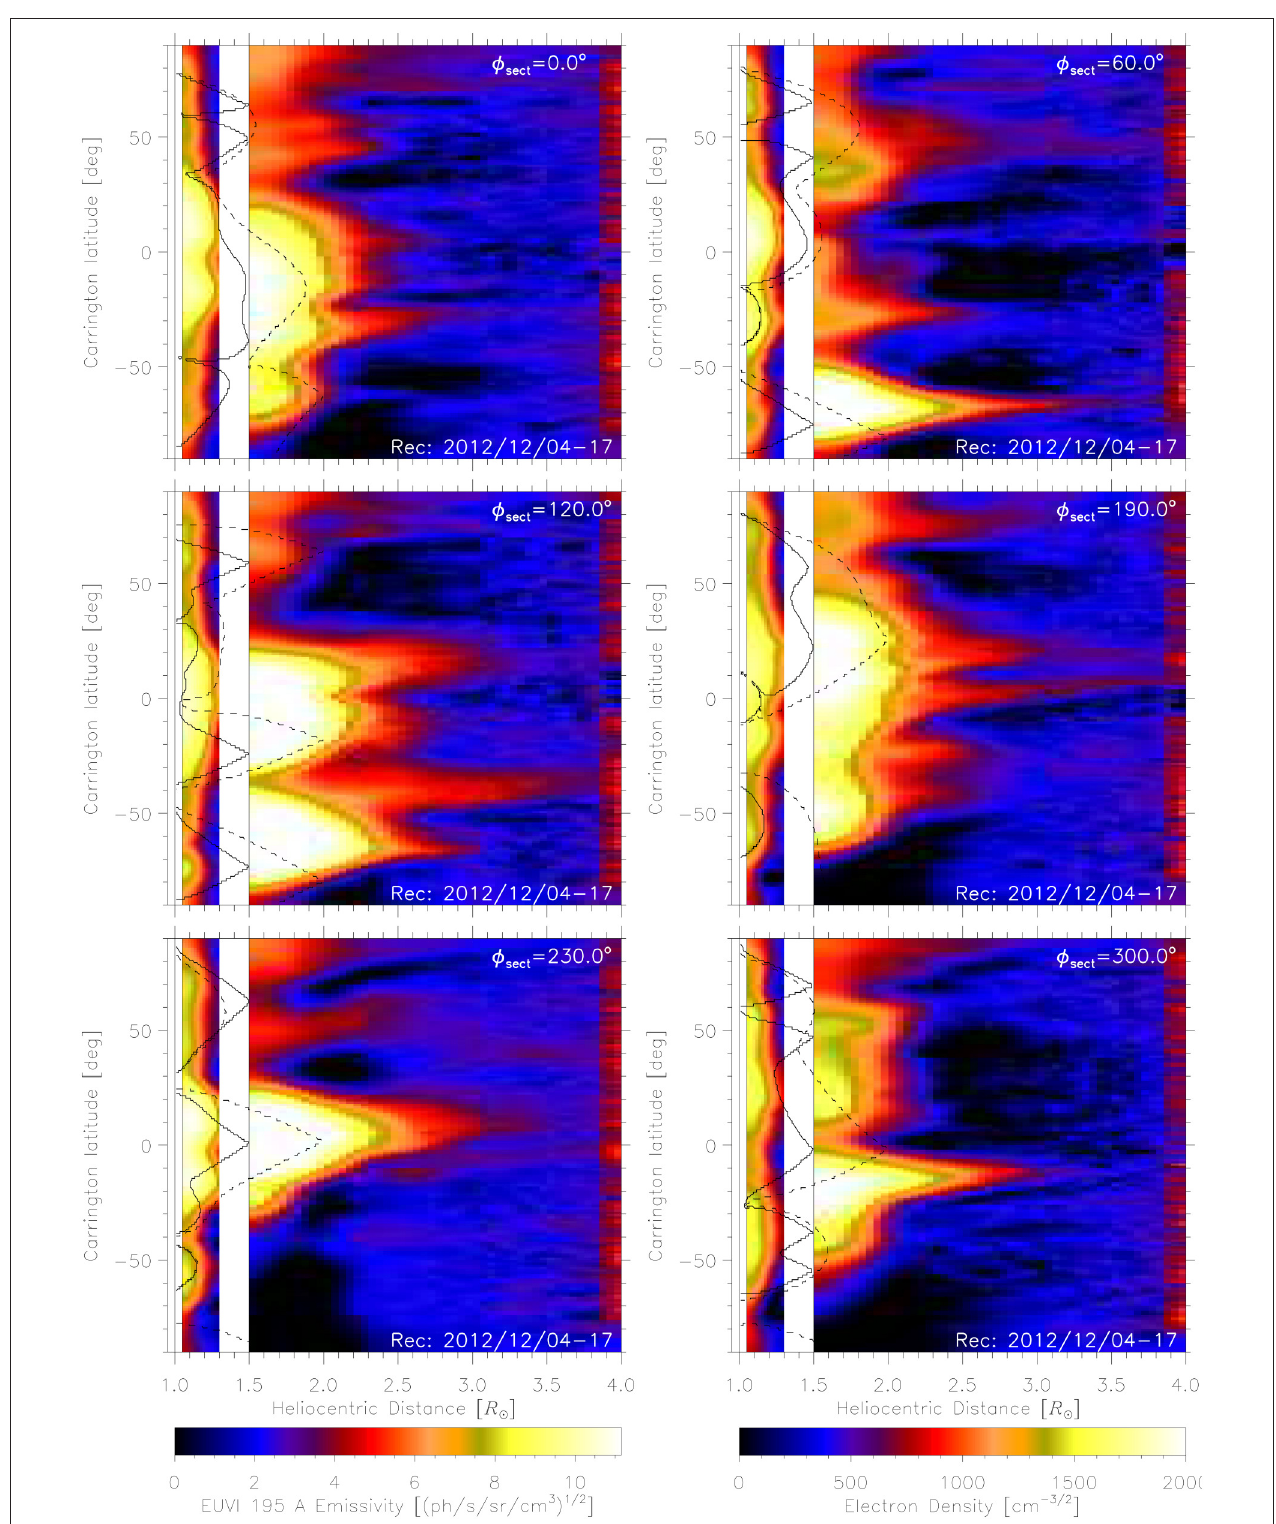
FIGURE 3 | Reconstructions for CR 2131 based on COR1 data (electron density in the range from 1.5 to 4 R ⊙ ) and EUVI 195 Å data (emissivity in the range from 1.05 to 1.29 R ⊙ ). Carrington longitudes for cross-sections are shown at upper right corners. The figure with a set of all cross-sections is available in the Electronic Supplementary Material. The contour black lines show boundaries between open and closed magnetic-field structures for the PFSS models with Source Surface located at 1.5 and 2.0 R ⊙ .